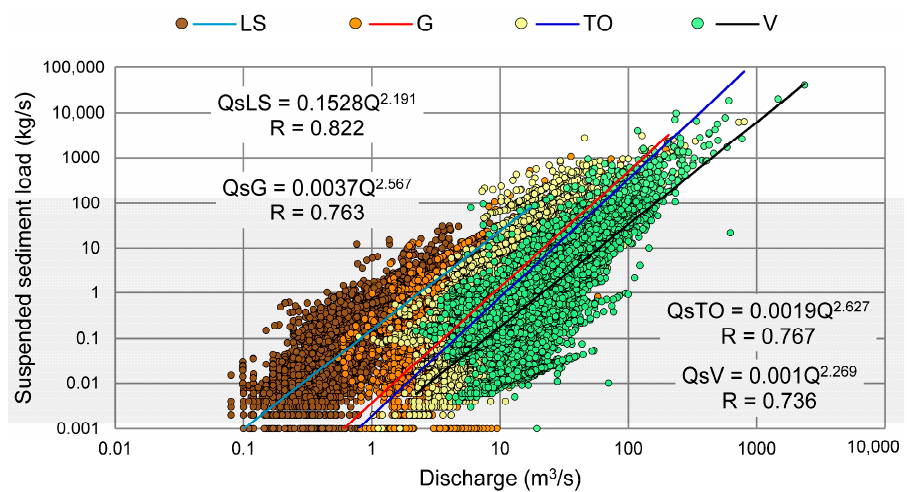
Figure 3. Relationship between water discharge and suspended sediment load at the four gauging stations along the Trotu ș River (1994–2014).